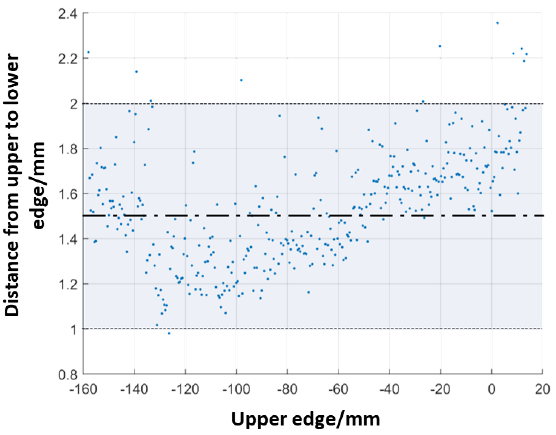
Figure 20. The distances between the upper and lower edge of the bevel end